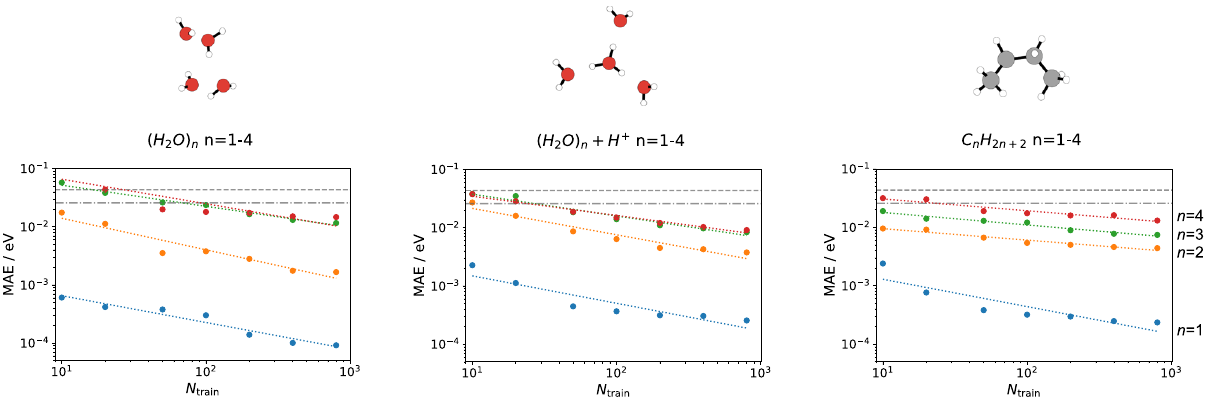
Fig. 2 Learning curves. Shown is the mean absolute error (MAE) vs number of training densities ( N train ) for the correlation energy in water clusters (left), protonated water clusters (center) and alkane con fi gurations (right). For reference, the dashed line denotes an error of 1 kcal mol − 1 ≈ 43 meV and the dash-dotted one an error of k B T ≈ 25 meV (at 300 K).